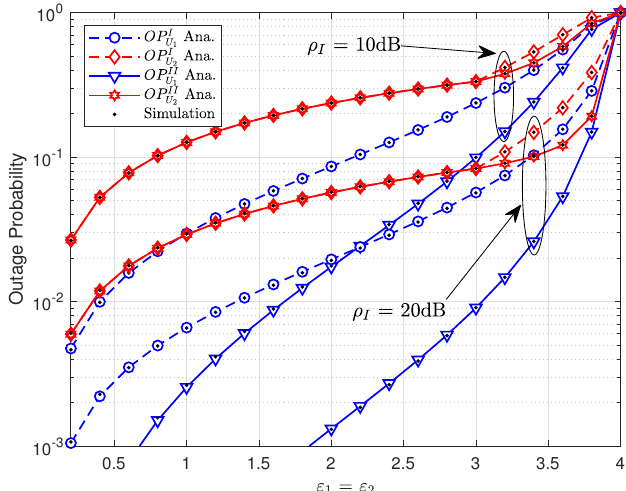
Figure 7. Comparison on two schemes for U 1 , U 2 with varying the target rate (cid:101) 1 = (cid:101) 2